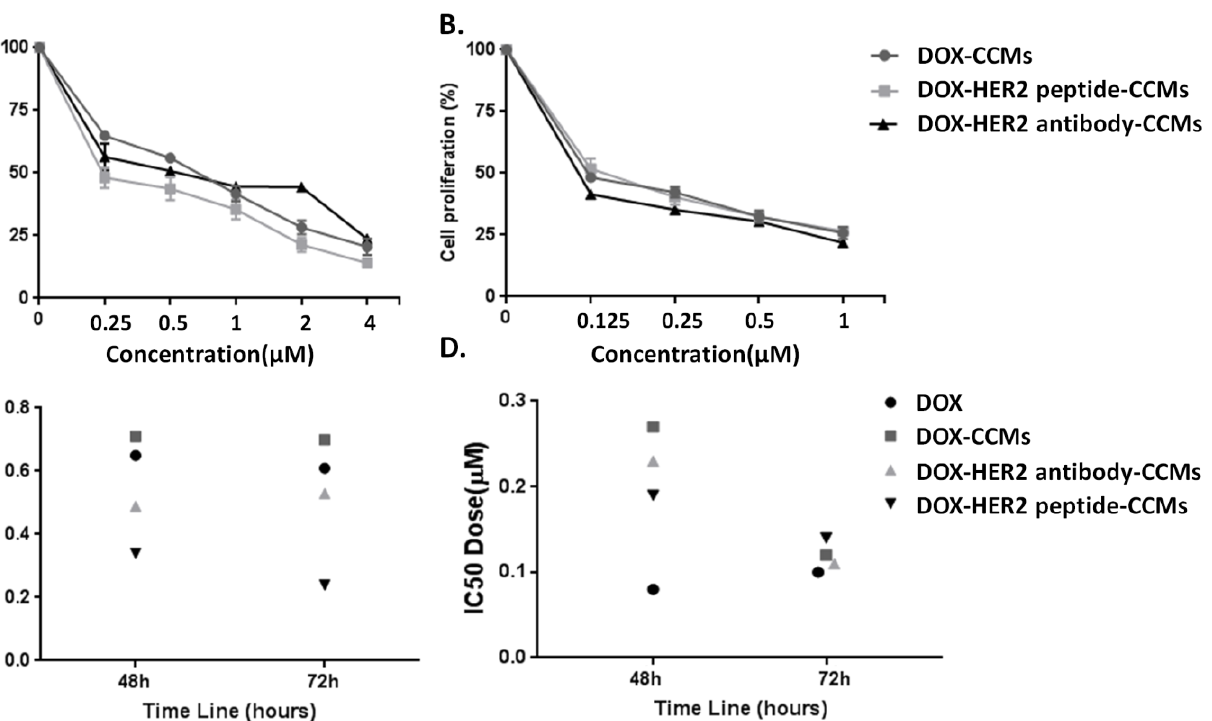
Figure 6. DOX-CCMs, DOX-HER2 peptide-CCMs, and DOX-HER2 antibody-CCMs (0 – 4 µM) on 72 SKBR-3 breast cancer ( A ) and (0–1 µ M) cytotoxic effect on MCF-10A ( B ) cells and SKBR-3 ( C ) and h SKBR-3 breast cancer ( A ) and (0 – 1 µM) cytotoxic effect on MCF-10A ( B ) cells and SKBR-3 ( C ) and MCF-10A ( D ) IC50 dose distribution of cells at 48 and 72 MCF-10A ( D ) IC50 dose distribution of cells at 48 and 72 h.